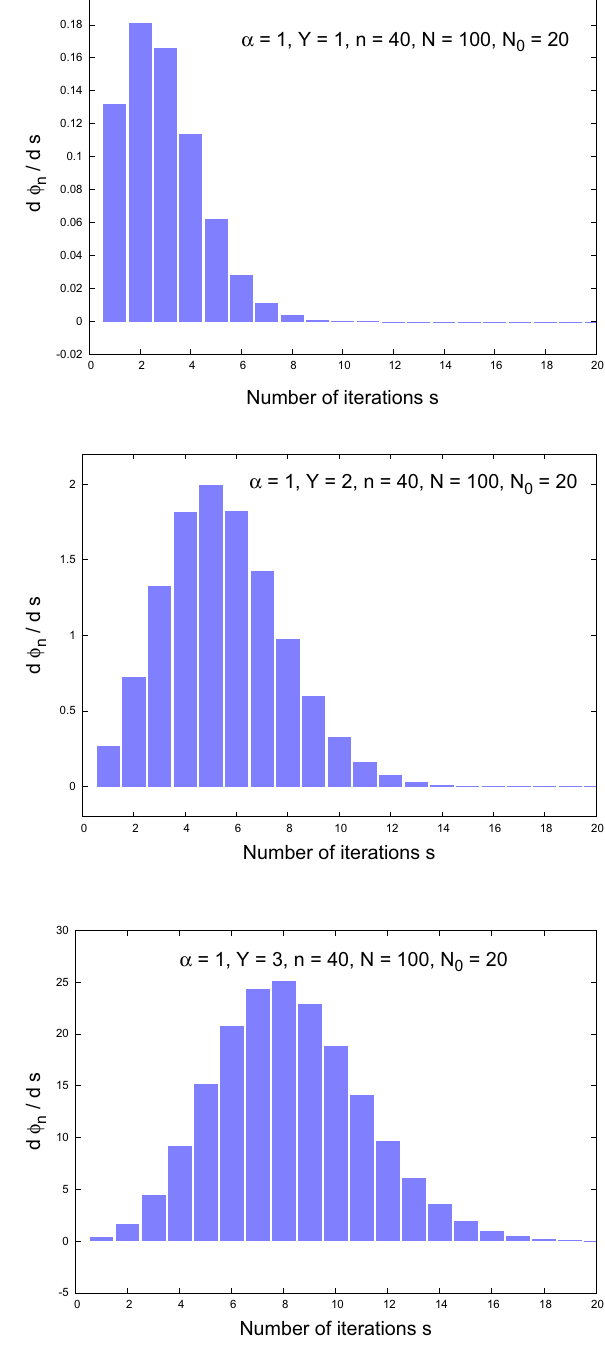
Fig. 10 Distribution in the number of iterations of the Hamiltonian for fixed α, N , n ,